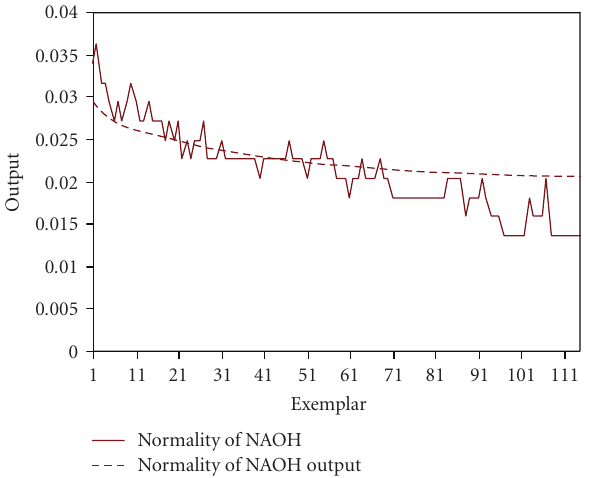
Figure 4: Desired output and Network output for testing data set (FTLR NN model-Lab.